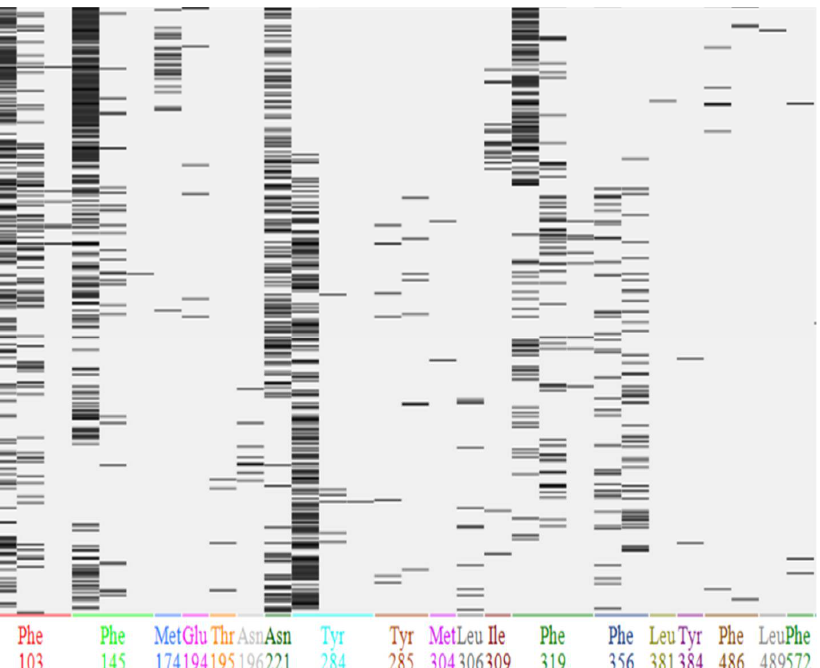
Figure 6. Results of PLIF analysis for the interaction of BCO2 with β-carotene. Fingerprints are shown for each residue of the ligand-interaction protein. Each line represents an interaction of the due residue with one atom of the ligand at 100 ns of simulation.